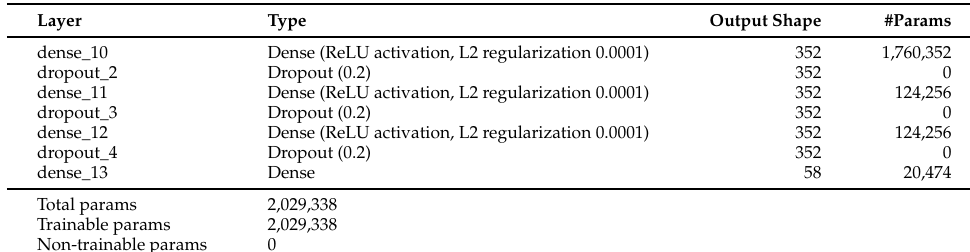
Table 7. Details of MLP